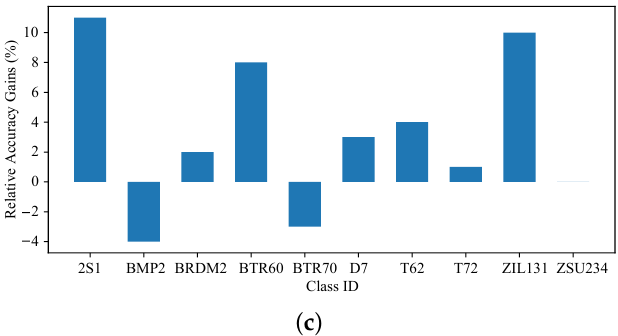
Figure 7. Precision comparisons for each class of the MBM and other mixed semi-supervised methods, where the Y-axis denotes the per class classification accuracy improvement of the MBM relative to another mixed semi-supervised method, and the X-axis denotes the class index of each category.